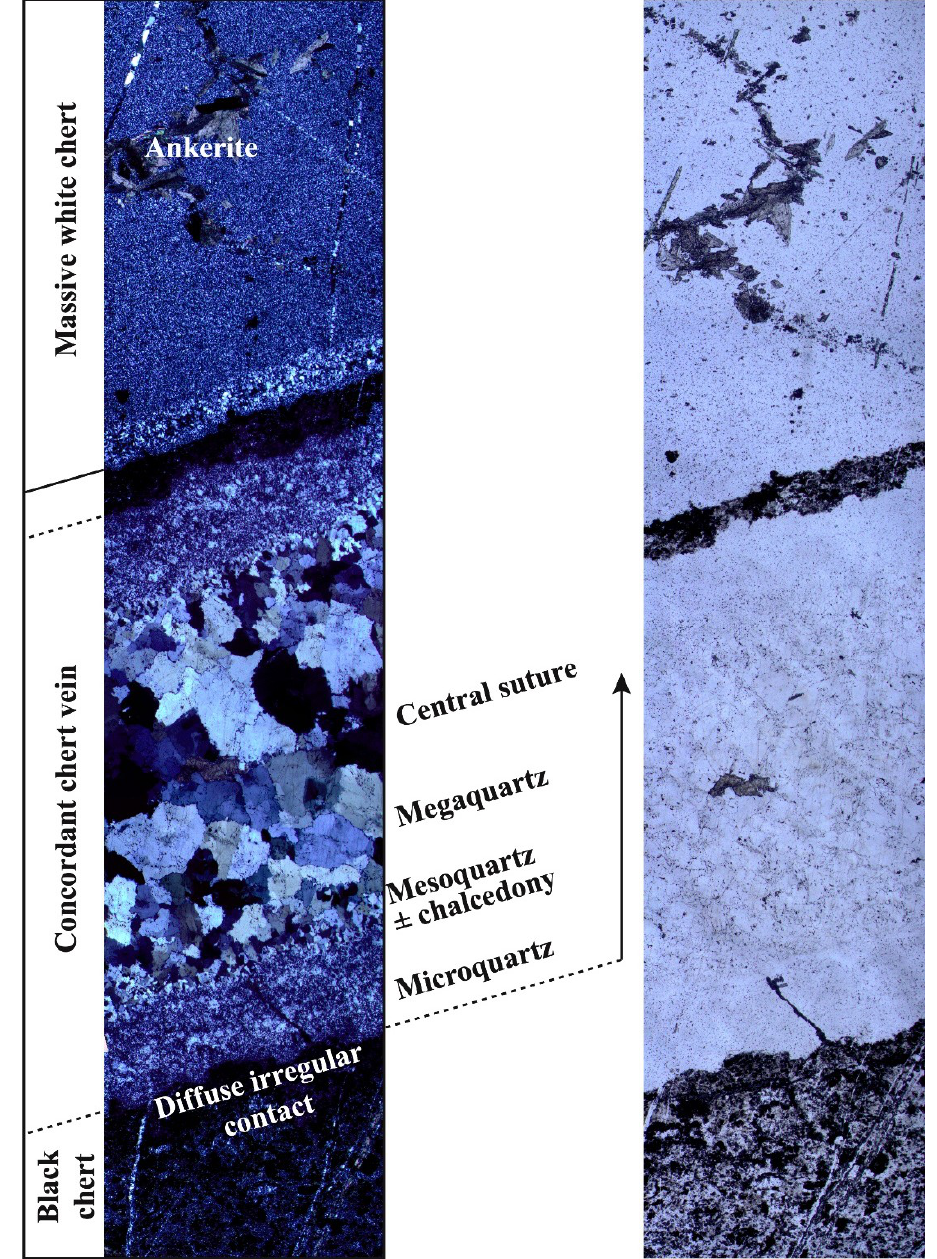
Figure 7. Natural (right) and polarized (left) photomicrographs showing the petrologic evolution from a massive black chert (base) to massive white chert (top), with an intermediate concordant quartz-filled vein. The vein displays a specific internal organization: at the contact, it comprises microquartz that evolves to mesoquartz and megaquartz when going towards the center. The micro- to megaquartz transition is abrupt over less than 0.2 mm.